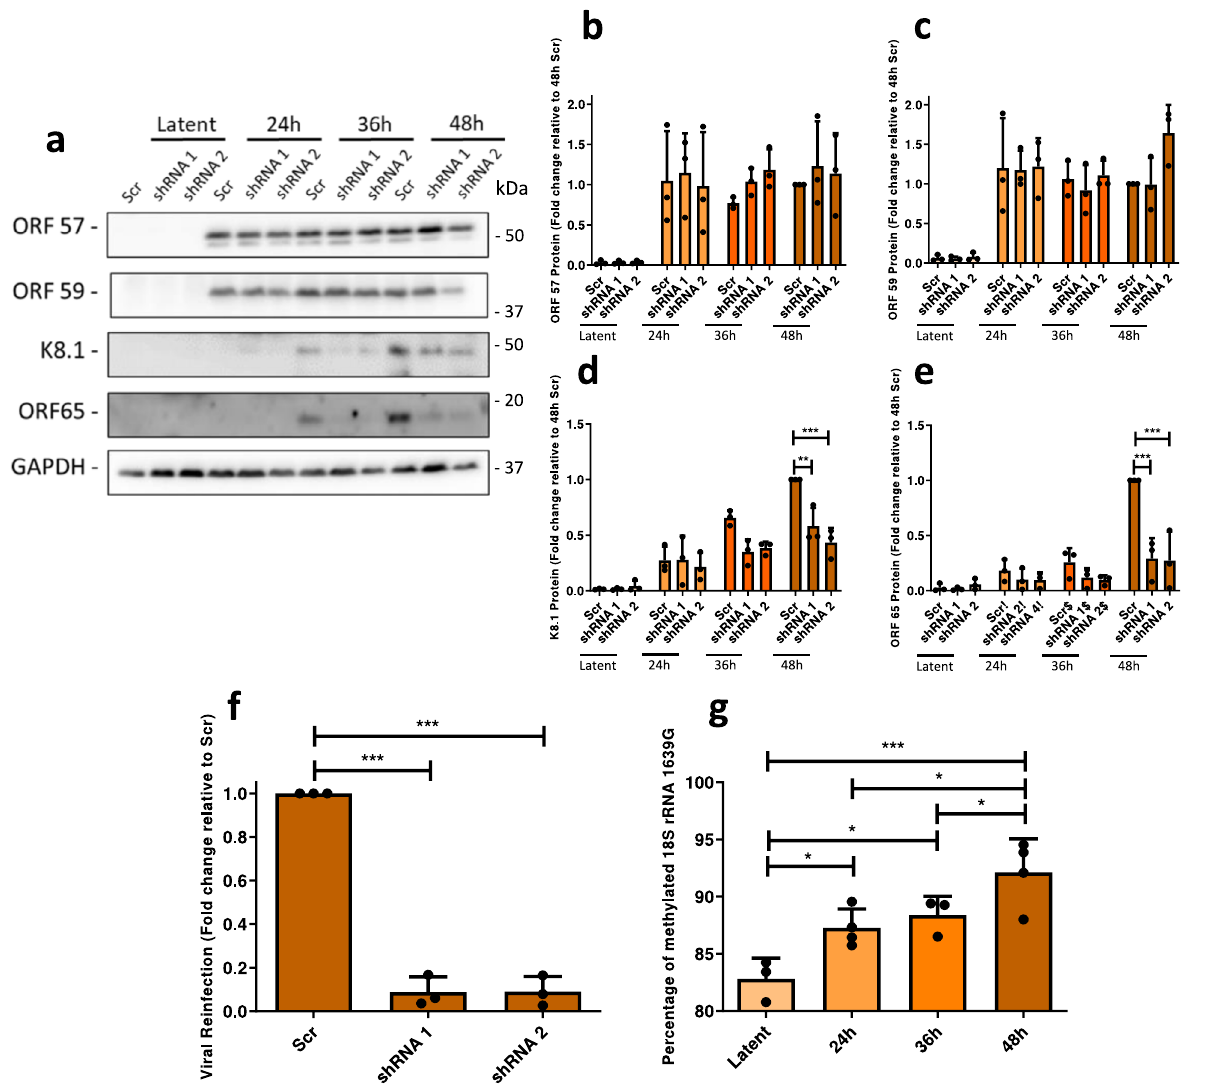
Fig. 3 | Depletion of BUD23 does not affect early KSHV lytic replication but signi fi cantly impacts the late stages. TREx BCBL1-Rta cells expressing a Scr shRNA or two different shRNAs targeting BUD23 were used for a time course of KSHV lytic reactivation over 48h, with samples collected at 0 (latent), 24, 36 and 48h ( n =3 biologically independent samples). a Whole cell lysates were collected andanalysedbywesternblotprobing earlyKSHVlyticproteins,ORF57andORF59, late KSHV lytic proteins, K8.1 and ORF65, and GAPDH was included as a loading control. b – e Densitometric analysis of ORF57, ORF59, K8.1 ( p =0.0045 and <0.0001) and ORF65 ( p ≤ 0.0001 for both) relative to GAPDH are shown. f Lytic reactivation of KSHV was induced in TREx BCBL1-Rta cells expressing a Scr shRNA ortwodifferentshRNAstargetingBUD23for72h.VirusreleasedfromTRExBCBL1- Rta cell lines was collected and HEK 293T cells re-infected with the virus for